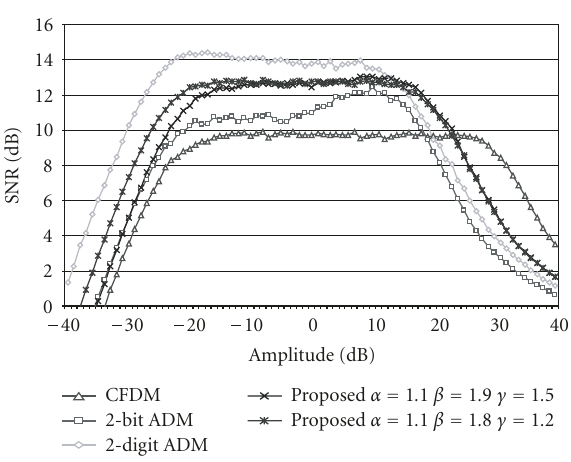
Figure 6: SNR values for di ff erent amplitudes of a speech input signal for the same output bit rate (dynamic range of step size: ±